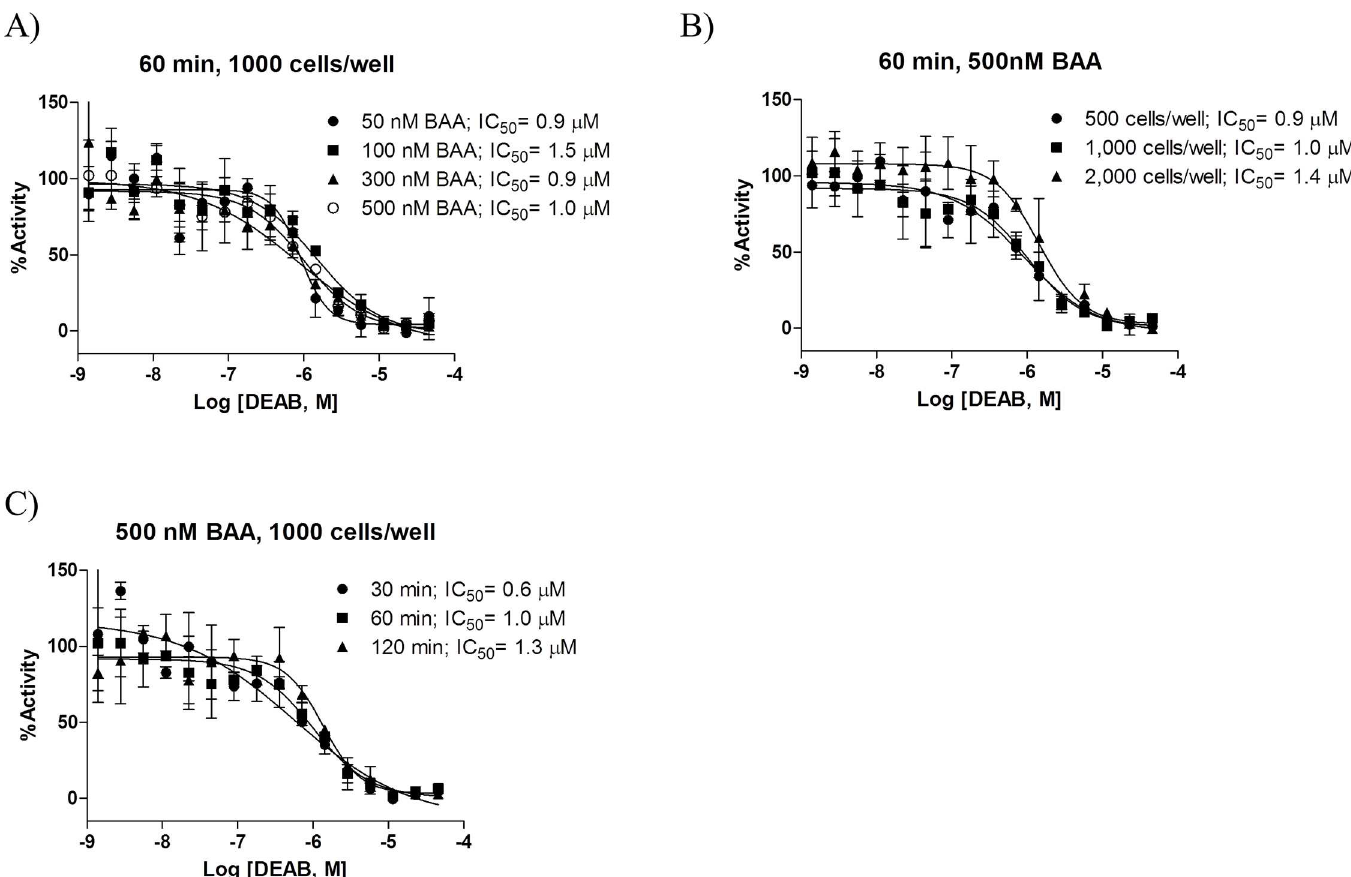
Fig 2. Assayminiaturization to 1,536-well format. (A) DEAB dose responsecurves of 1,000 MIA PaCa-2 cells/wellincubatedwith the indicated concentration of BAAA substrate for 60 min. (B) DEAB dose responsecurves of indicatednumber of MIA PaCa-2 cells/well incubatedwith 500 nM of BAAA substrate for 60 min. (C) DEAB dose response curves of 1,000 MIA PaCa-2cells/wellincubatedwith the indicatedconcentration of BAAA substrate for 60 min. Data are represented as mean +/- SD, n = 3, and normalizedto DMSO (100% activity) and 4.6 μ M DEAB (0% activity).